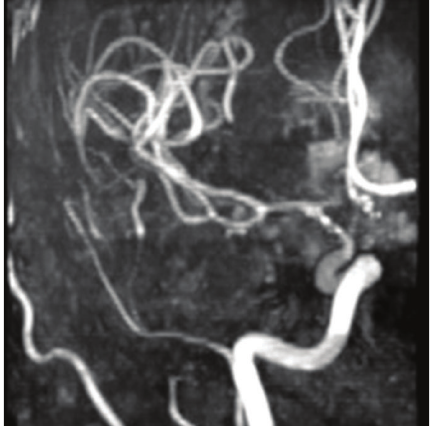
F 5: MR Angiography. Vasospasm of the supraclinoid le internal carotid artery, middle cerebral artery, and anterior cerebral artery demonstrated on time of �ight